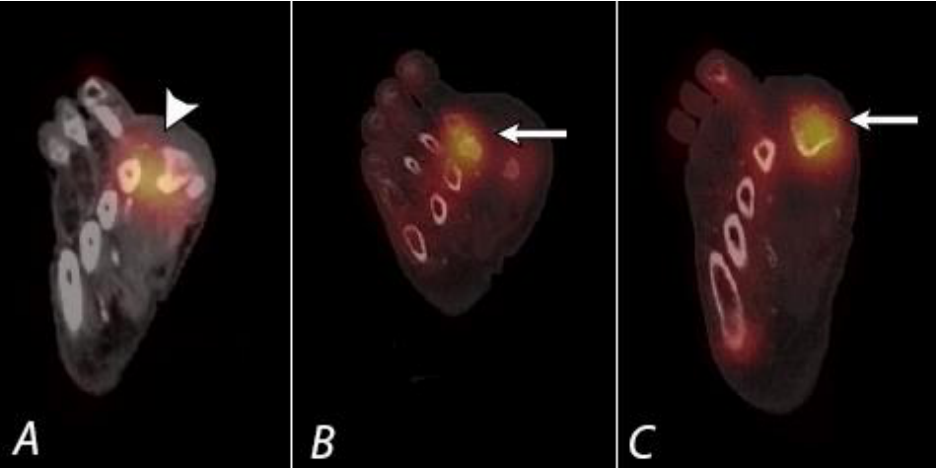
Figure 12. Fifty-eight-year-old diabetic male with history of right great toe amputation (at the MTP joint) 2 months previously, now with new pain, swelling, and redness in the medial forefoot. 99m Tc MDP SPECT/CT bone scan ( B , C ) shows increased uptake at the first metatarsal head and the second MTP joint (white arrows). An 111 In WBC SPECT/CT scan ( A ) shows concordant uptake as well as a larger area of soft tissue uptake around first metatarsal head and the second MTP joint, confirming cellulitis in addition to osteomyelitis (white